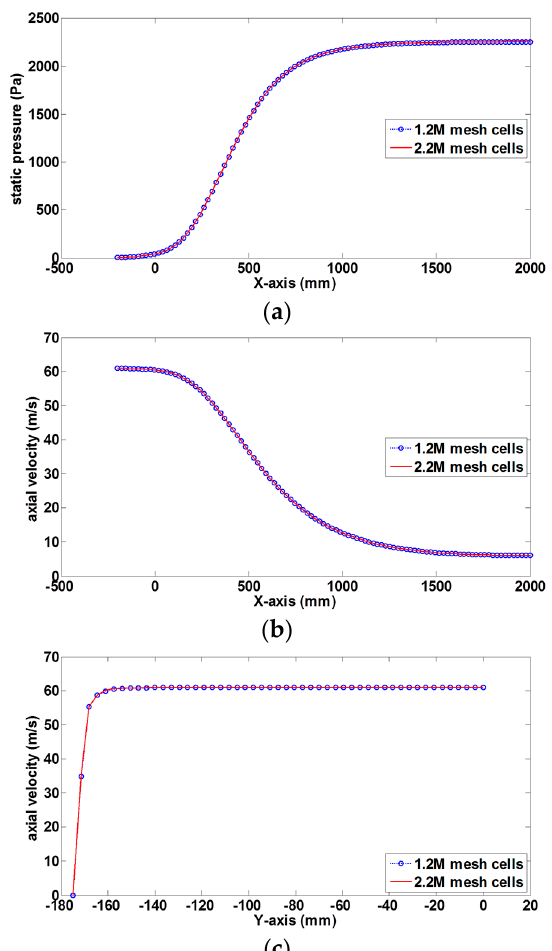
Figure 4. Pressure and velocity profiles along centerline and velocity profiles from two different mesh density settings, ( a ) pressure profile along centerline; ( b ) velocity profile along centerline; ( c ) velocity profile at contraction exit.